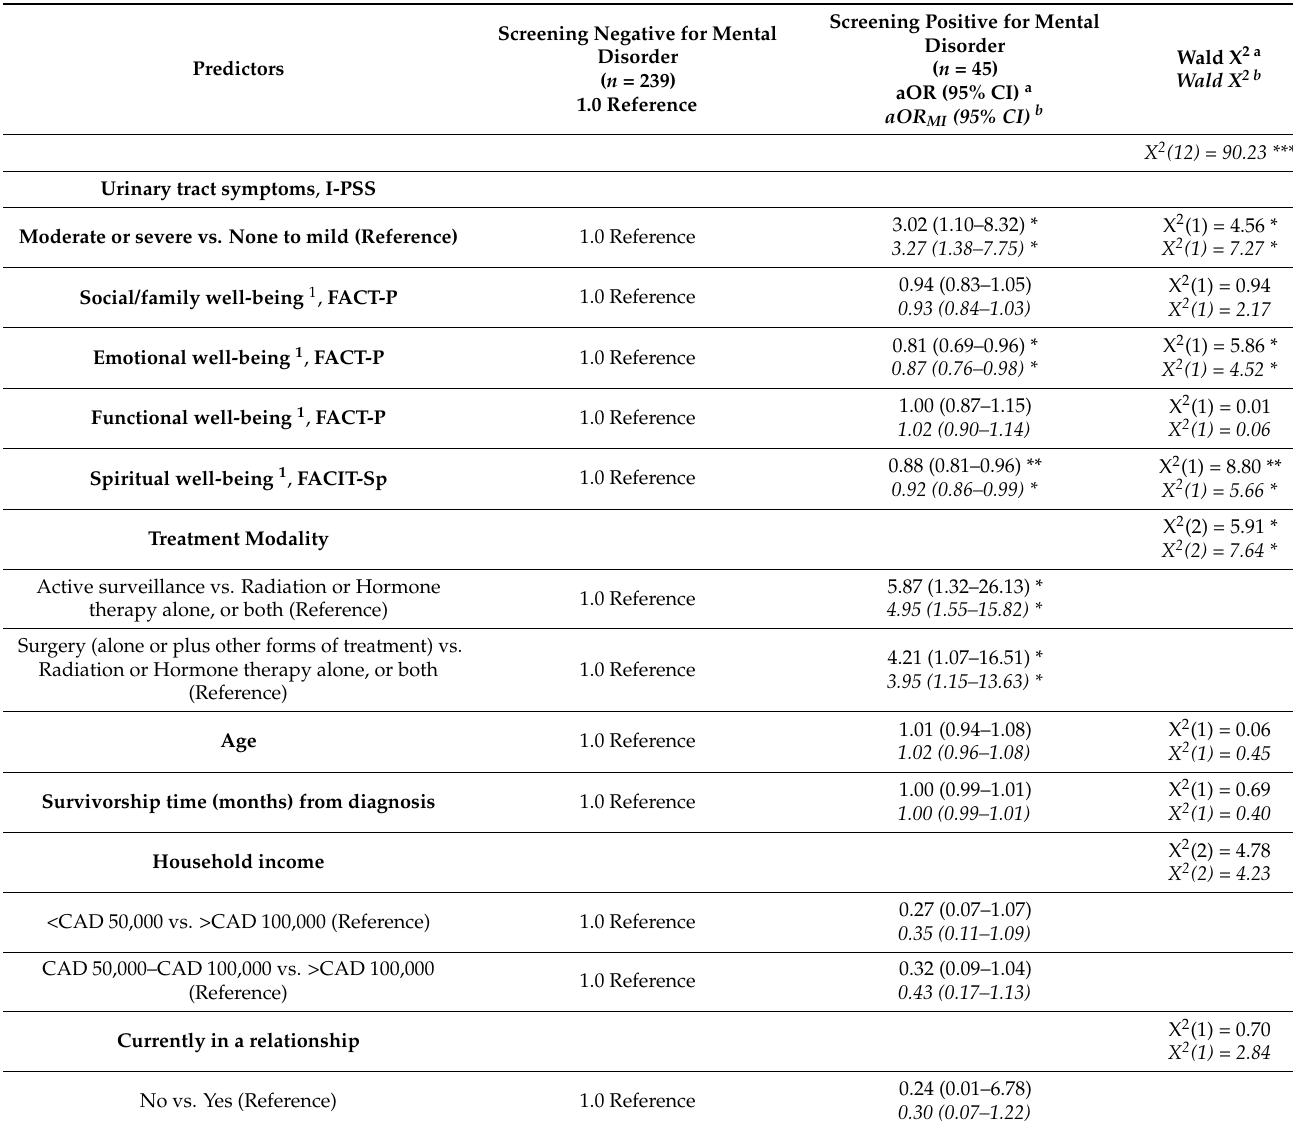
Table 3. Multivariate logistic regression modelling the relationship between mental disorder and social/family, emotional, functional and spiritual well-being, urinary function, treatment modality and demographic variables in a sample of men with a history of prostate cancer diagnosis from the baseline cycle of a Quality-of-Life Maritimes Survey administered between 2017 and 2021, n =